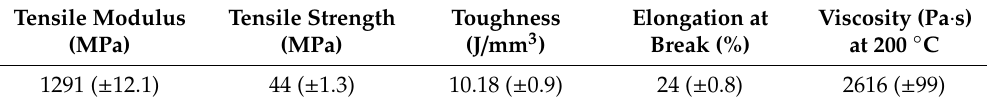
Table 2. Mechanical and viscosity properties of